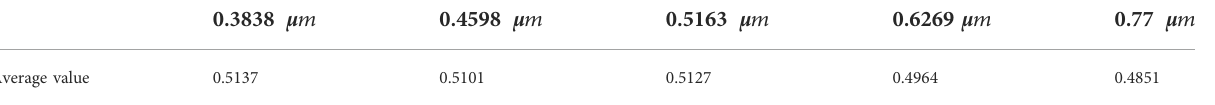
TABLE 1 Extinction values measured at different wavelengths.